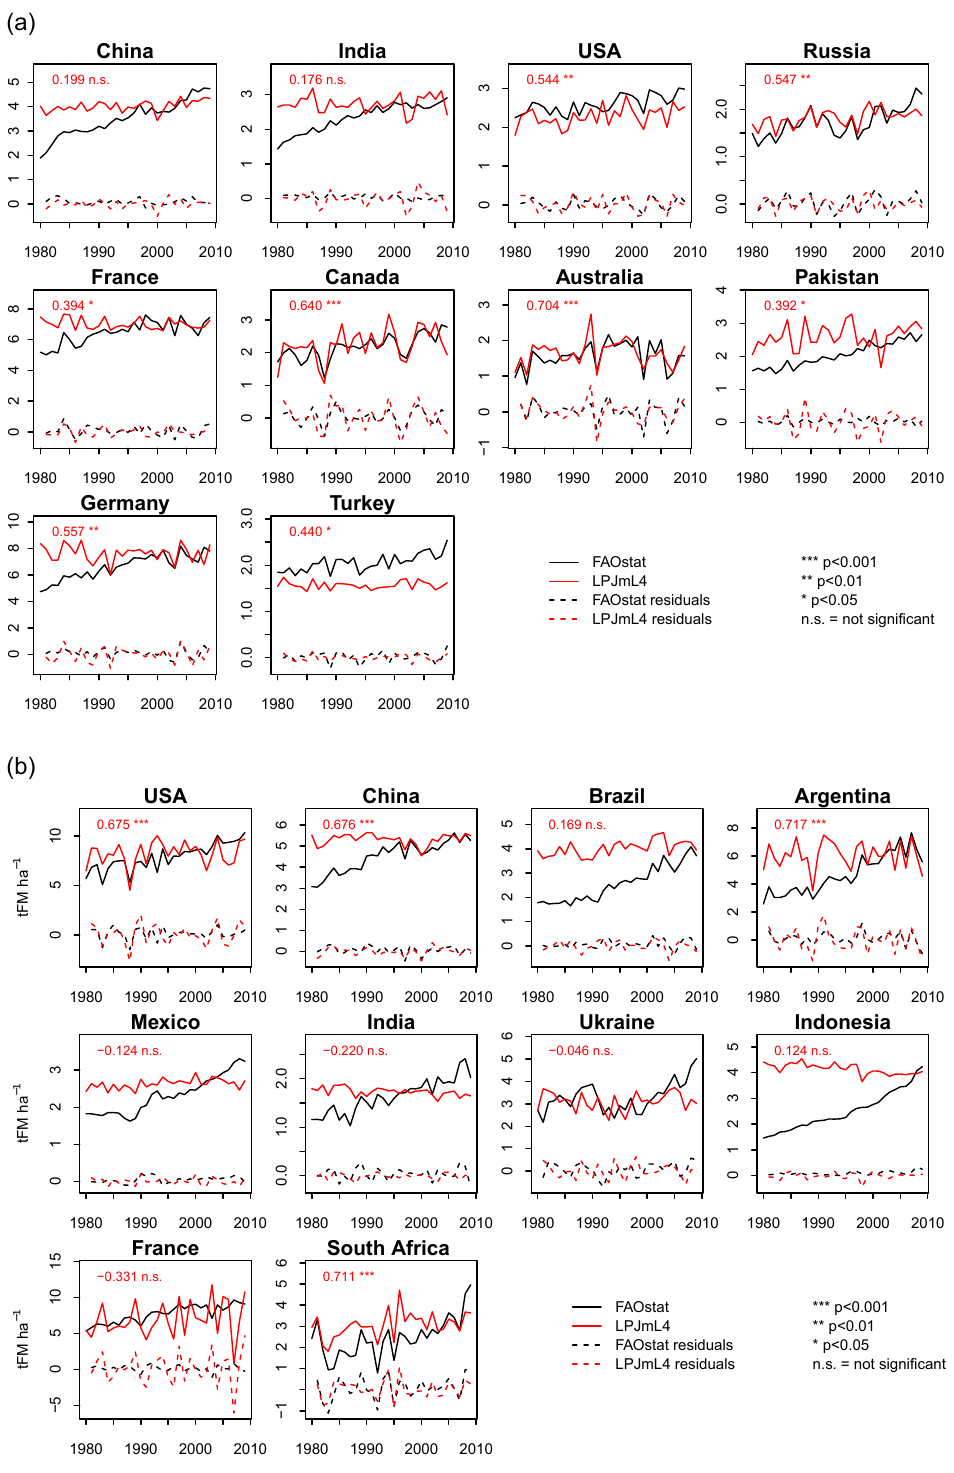
Figure 12. Evaluation of simulated yield variability for wheat (a) and maize (b) in comparison to FAO data (http://www.fao.org/faostat/en/